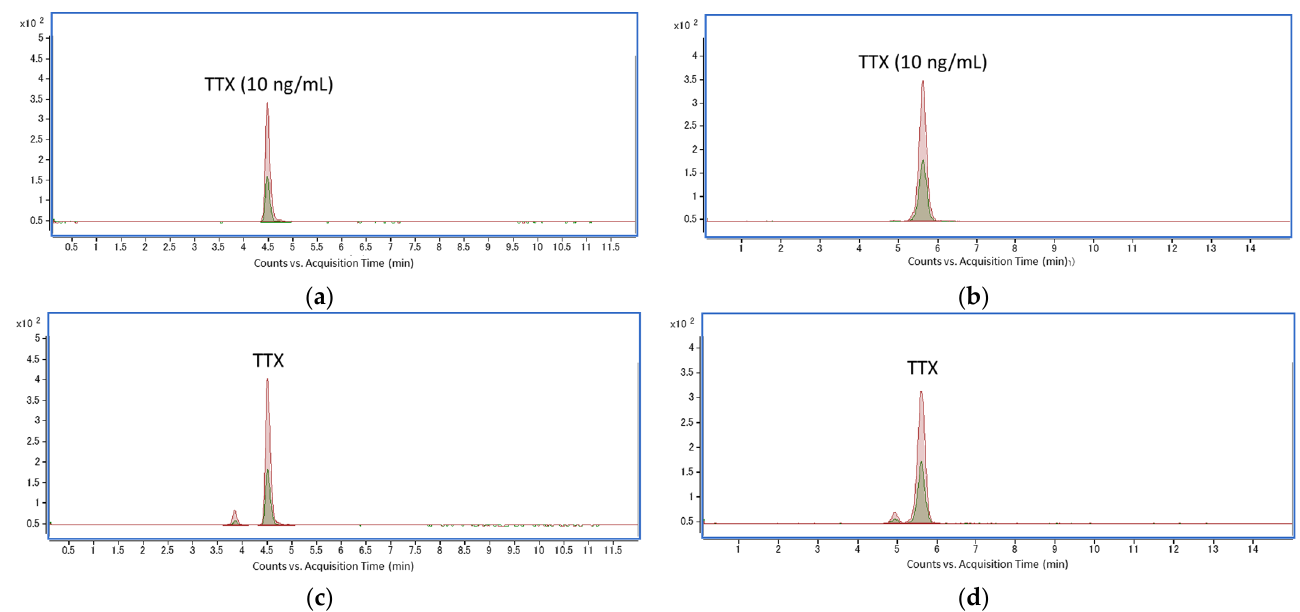
Figure 3. The toxic specimens of the puffer fish, Takifugu flavipterus , captured from Seto Inland Sea, Japan. ( a ) NIHS-puf- 150040: without freeze–thaw, but not in good condition. ( b ) NIHS-puf-150051, ( c ) 150052, and ( d ) 150054: freeze–thawed before cutting into each tissue (flesh and skin). ( e ) NIHS-puf-150091 and ( f ) 150097: not freeze–thawed.